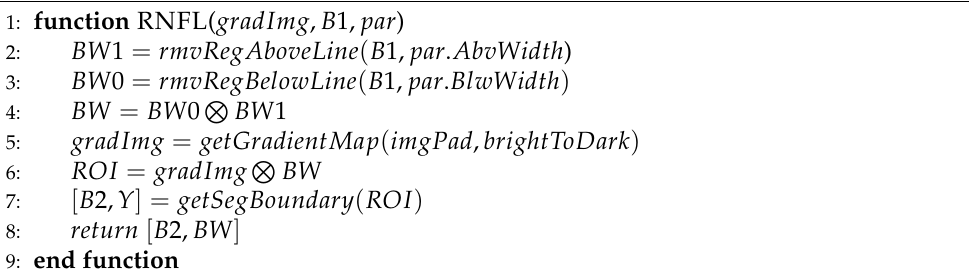
Figure 4. Computing the areas of interest for each layer: B2, B4, B6 and B7 ( left ) and B1, B3, B5 and B8 ( right ). Algorithm 2 RNFL segmentation by firstly computing its region of interest.